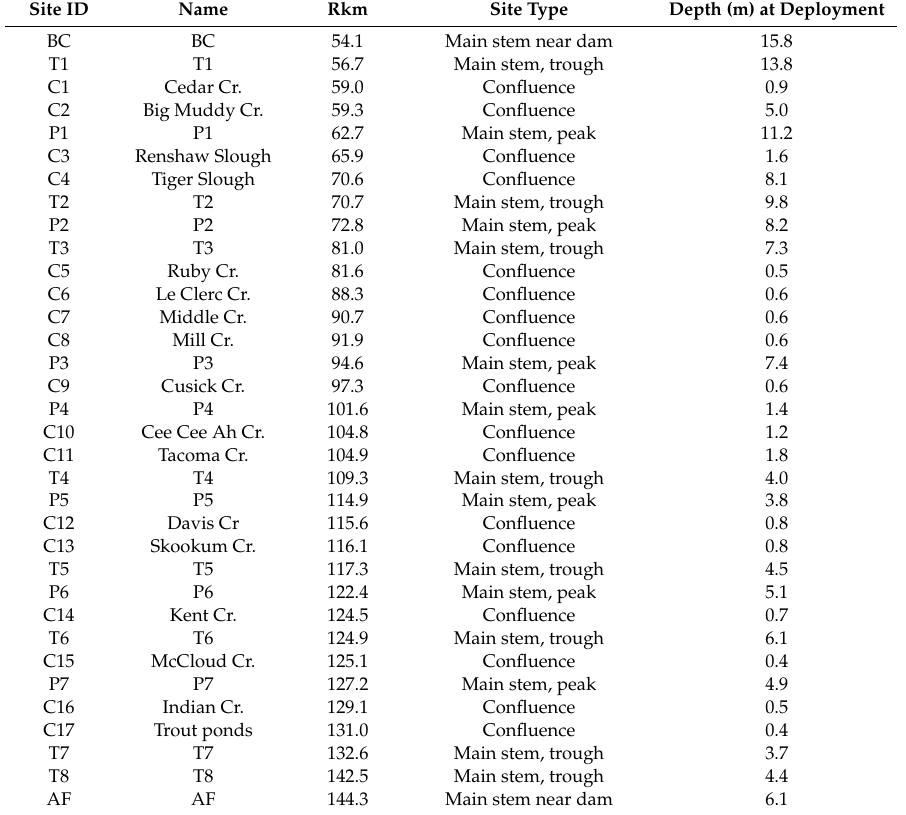
Table 1. Site identification and name for instream loggers and their corresponding river kilometer (rkm) location and depth at deployment. Main stem sites are labeled as either P (peaks) or T (troughs) and tributary confluences are labeled as